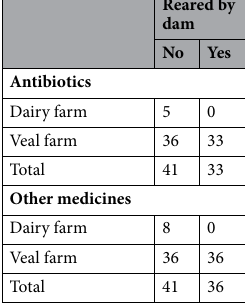
Table 4. Percentage of calves that were treated individually with antibiotics or other medicines (anti- inflammatory, anti-coccidiosis or vitamins) based on rearing practice.